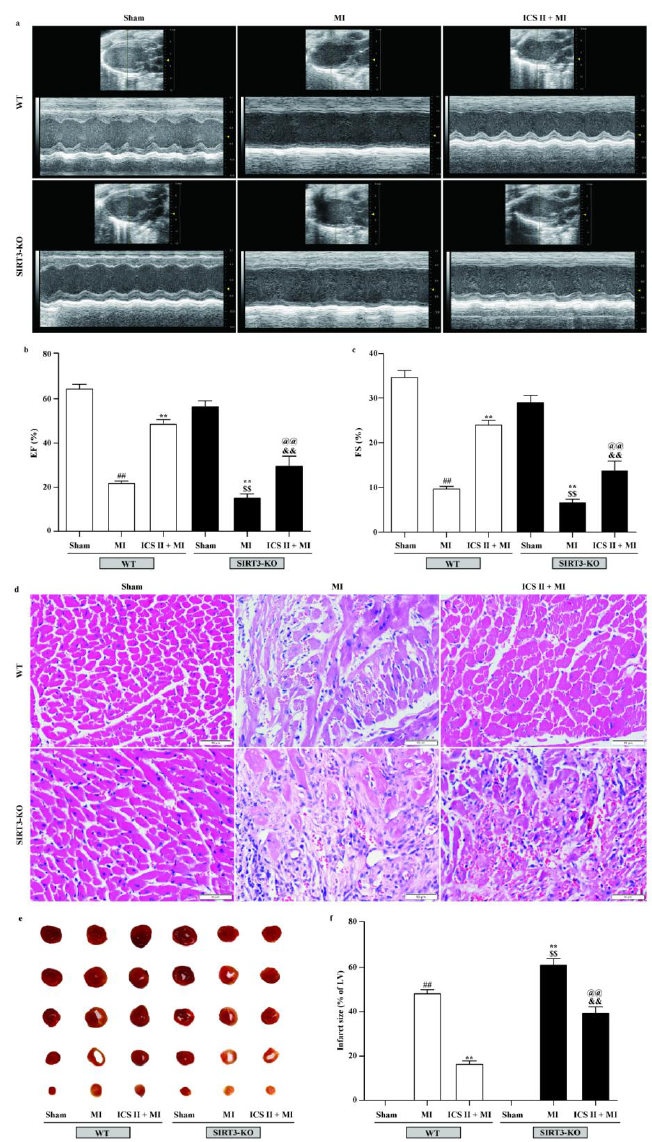
Figure 10. Effect of ICS II on SIRT3-KO mice: ( a ) cardiac function was measured using Doppler echocardiography; ( b ) EF (%) ( n = 6); ( c ) FS (%) ( n = 6); ( d ) HE staining was performed to observe the pathological changes in the left ventricle. Magnification × 400; scale bar, 50 μm; ( e ) myocardial infarct size was performed by TTC staining; ( f ) quantitative data of myocardial infarct size (%) ( n = 5). The data are presented as the mean ± SEM. ## p < 0.01 vs. sham (WT); ** p < 0.01 vs. MI (WT); $$ p < 0.01 vs. sham (SIRT3-KO); @@ p < 0.01 vs. MI (SIRT3-KO); && p < 0.01 vs. ICS II + MI (WT).